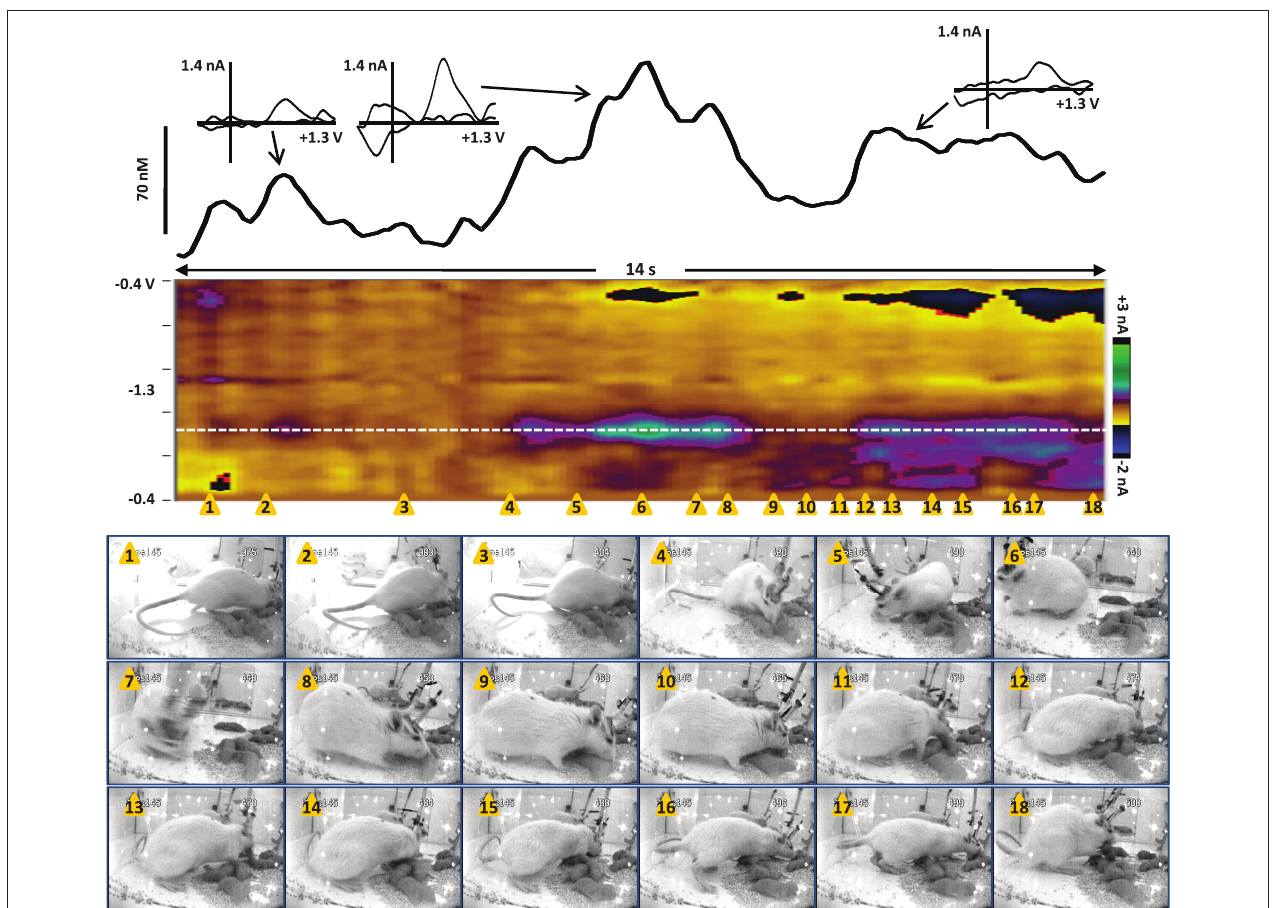
Figure 4 | Dopamine transients in the NAc core of a dam at the onset of retrieval after pups are returned (data also shown in Movie S2 in Supplementary Material). The color plot shows the changes in current at each applied potential over a 14-s window, and current at the oxidation potential of dopamine (white dotted line) is depicted in the line trace above the color plot. The timing of the snapshots is indicated by the orange triangles. This sequence begins 4 s after the pups were returned; for full description of the